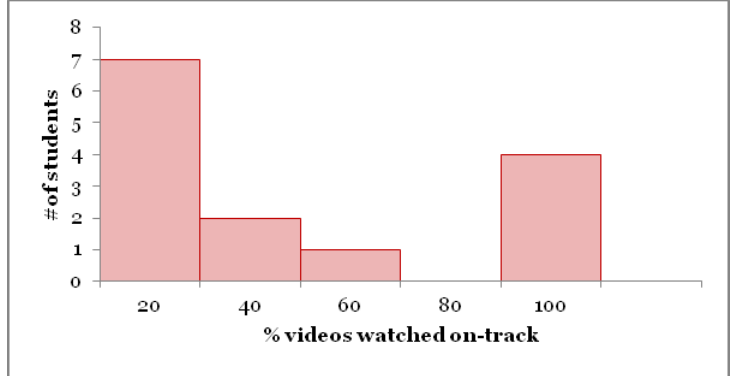
Figure 4. MOOC-only students’ pace of watching lecture videos.